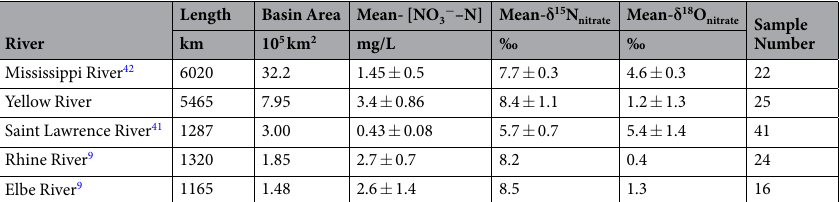
Table 1. Nitrate characteristics for long-term monitoring sites in large